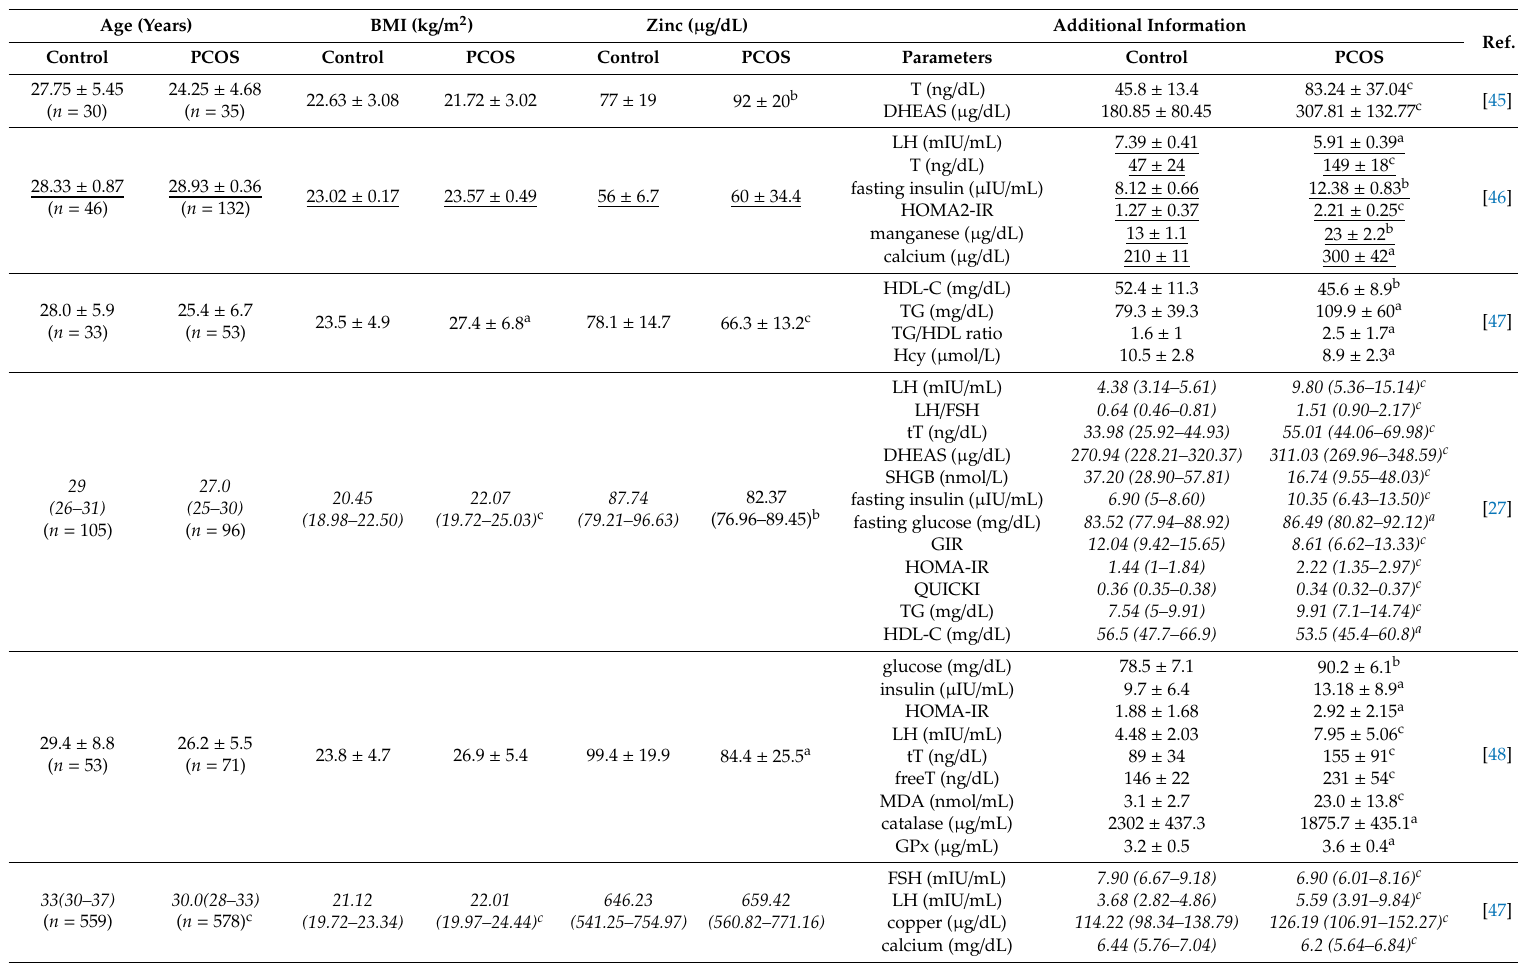
Table 2. Characteristics of women with polycystic ovary syndrome (PCOS), their serum zinc concentration and the statistically significant changes in various biochemical